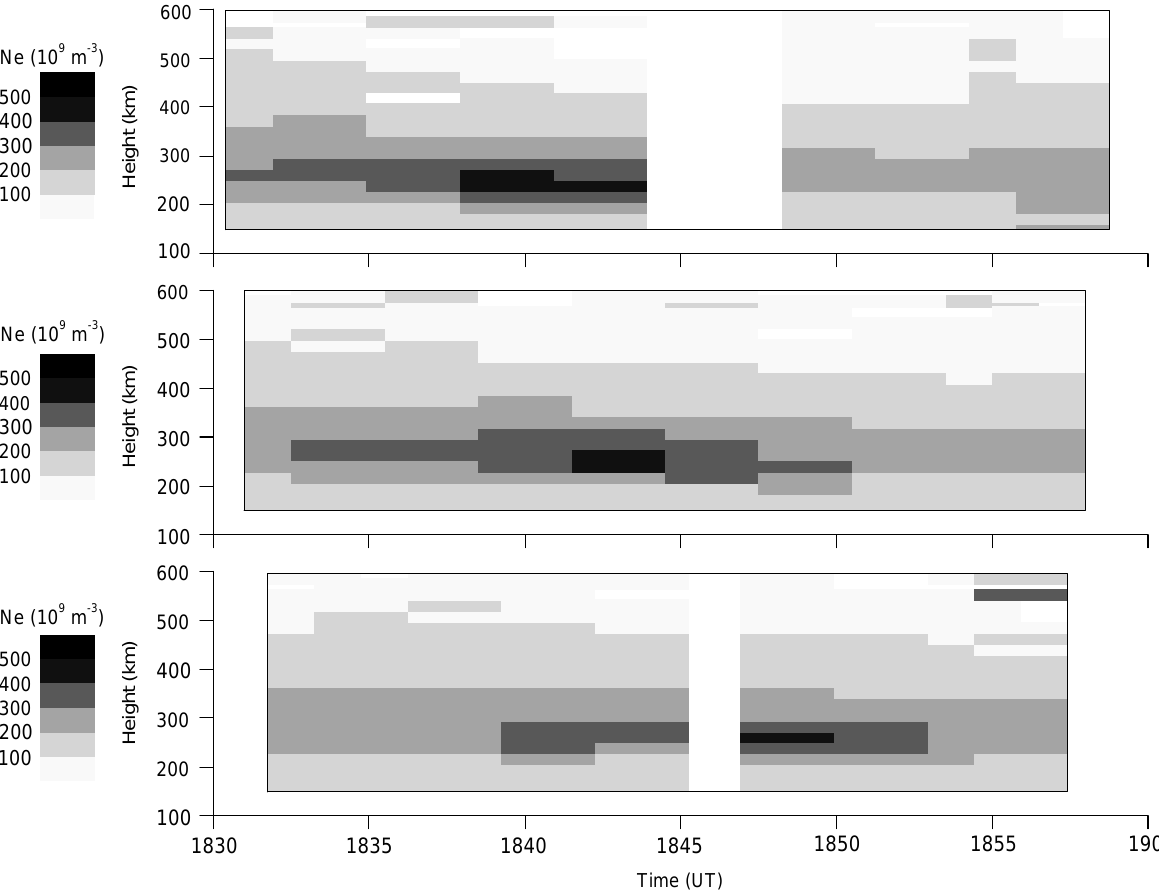
Fig. 4. Time series of EISCAT long-pulse electron-density contours taken from the experiment SP-UK-DYNA, 23 May 1994. The panels , from top to bottom, correspond to beam elevations 96 °